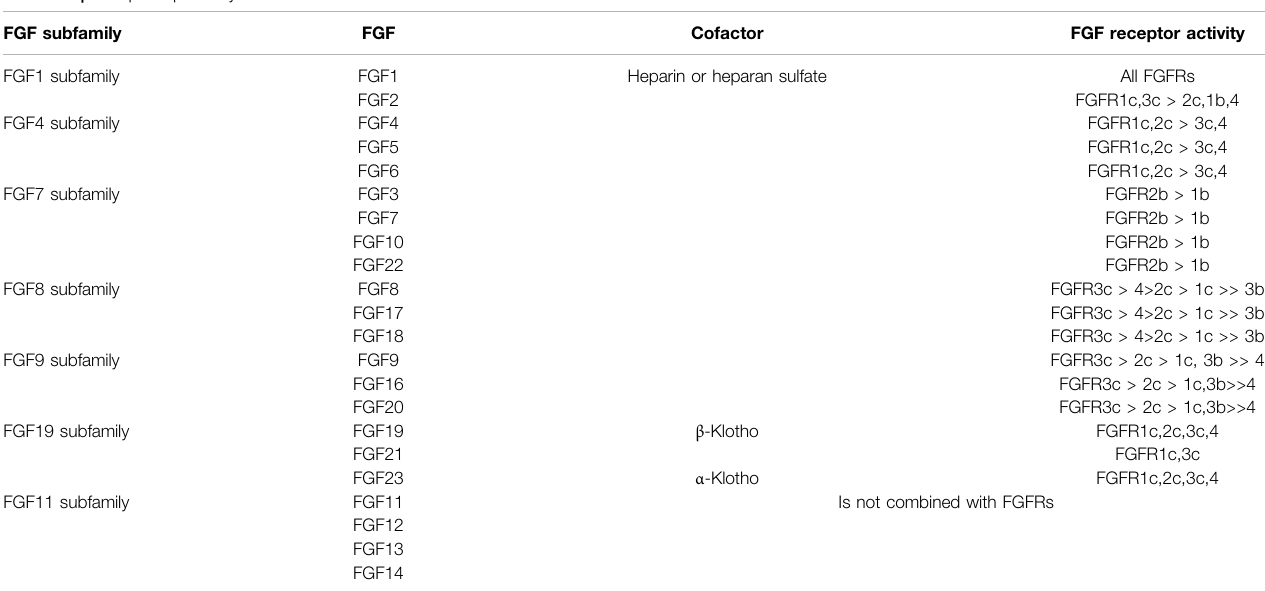
TABLE 1 | Receptor speci fi city of